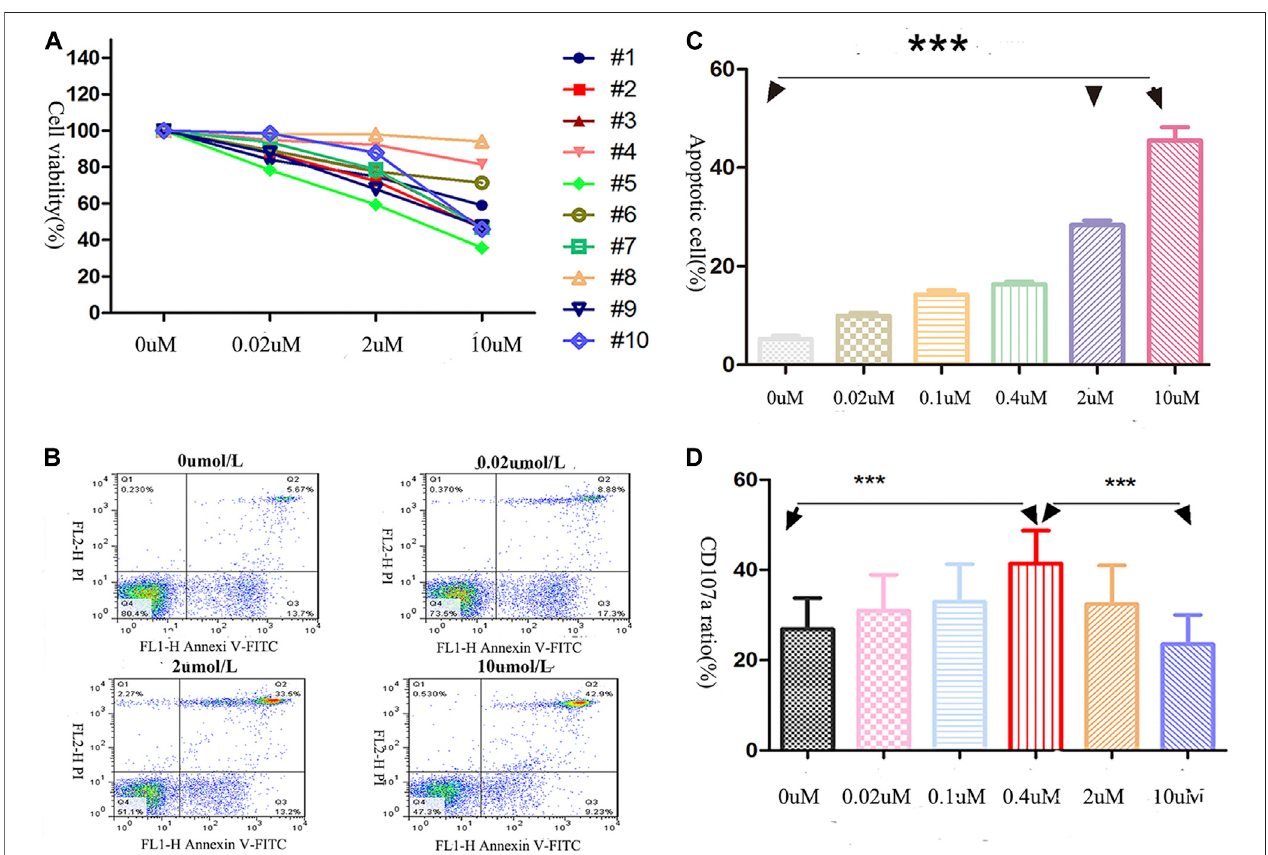
FIGURE1| EffectsofdecitabineexposureonprimaryNKcellsviabilityandcytotoxicity. (A) NKcellsviabilitywasassessedbyCCK-8assay.Afterbeingculturedfor 24 h (40,000 cells/well in 96-well plates), cells were incubated with CCK-8 solution for 4 h (B,C) The dead NK cells were visualized with annexin V/PI